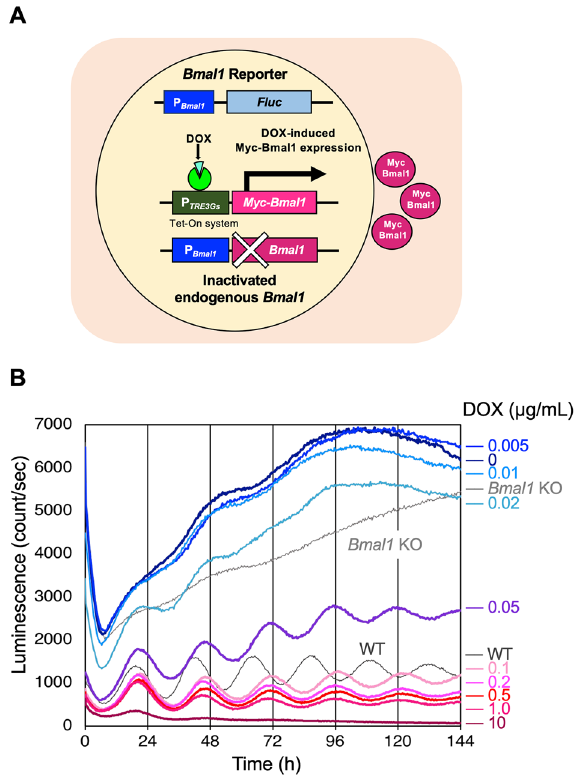
Figure 1. MYC-BMAL1 expression driven by a DOX-inducible promoter restores rhythmic Bmal1 promoter activity. ( A ) Schematic diagram of U2OS-P Bmal1 :: Fluc /Δ Bmal1 /P TRE3Gs :: Myc-Bmal1 strains. Endogenous Bmal1 was inactivated by CRISPR-Cas9 and a gene coding MYC-BMAL1 was expressed from the DOX-inducible promoter P TRE3Gs . Bmal1 promoter activity was monitored using the P Bmal1 :: Fluc reporter. We obtained seven strains (-2, -17, -23, -27, -33, -51, and -59). ( B ) Time course of luminescence measurements from the P Bmal1 ::